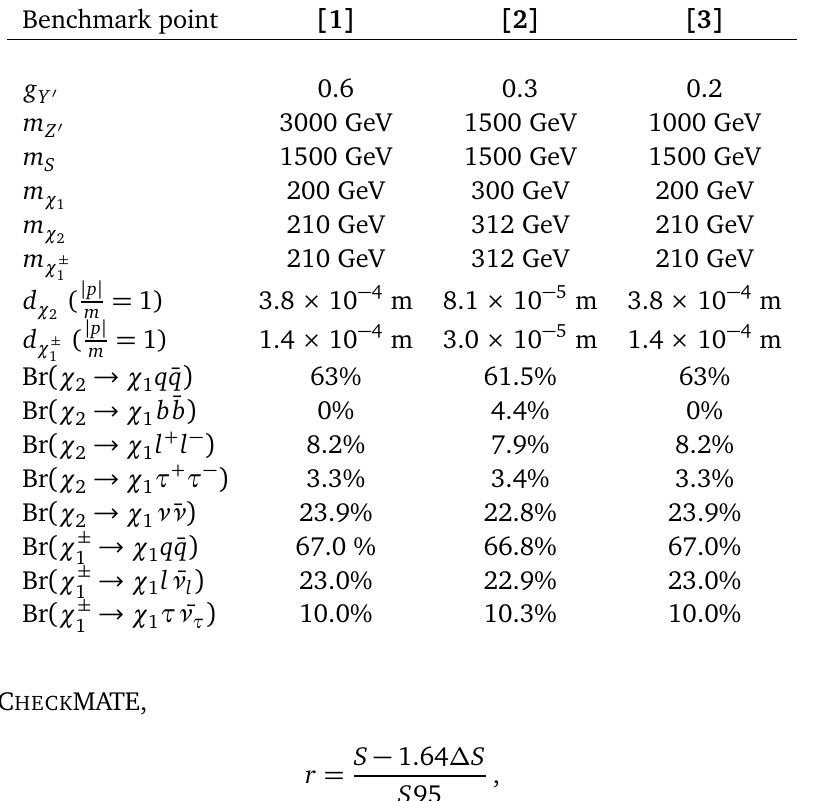
Table 1: Summary of benchmark points for scan of LHC searches which can explain the relic density while avoiding all other constraints. In the branching ratios q de- notes light quarks and l an electron or muon. The mixing in the neutral fermion sector is set to be small enough to avoid direct detection constraints, which will in general mean it’s small enough to be phenomenologically negligible for all other ob- servables except for the lifetimes of the heavier fermions. As an example of these lifetimes, the smallest 10 GeV splitting between χ and χ and ∆ m = 5% with a 2 1 mixing within direct detection bounds of points [ 1 ] , [ 3 ] give a χ lifetime of the 2 same order of magnitude as b -mesons ( ∼ 1.5 picosecond) and is therefore approach- ing the limit for where we can ignore searches for long-lived particles, especially for smaller masses where the boosts can be